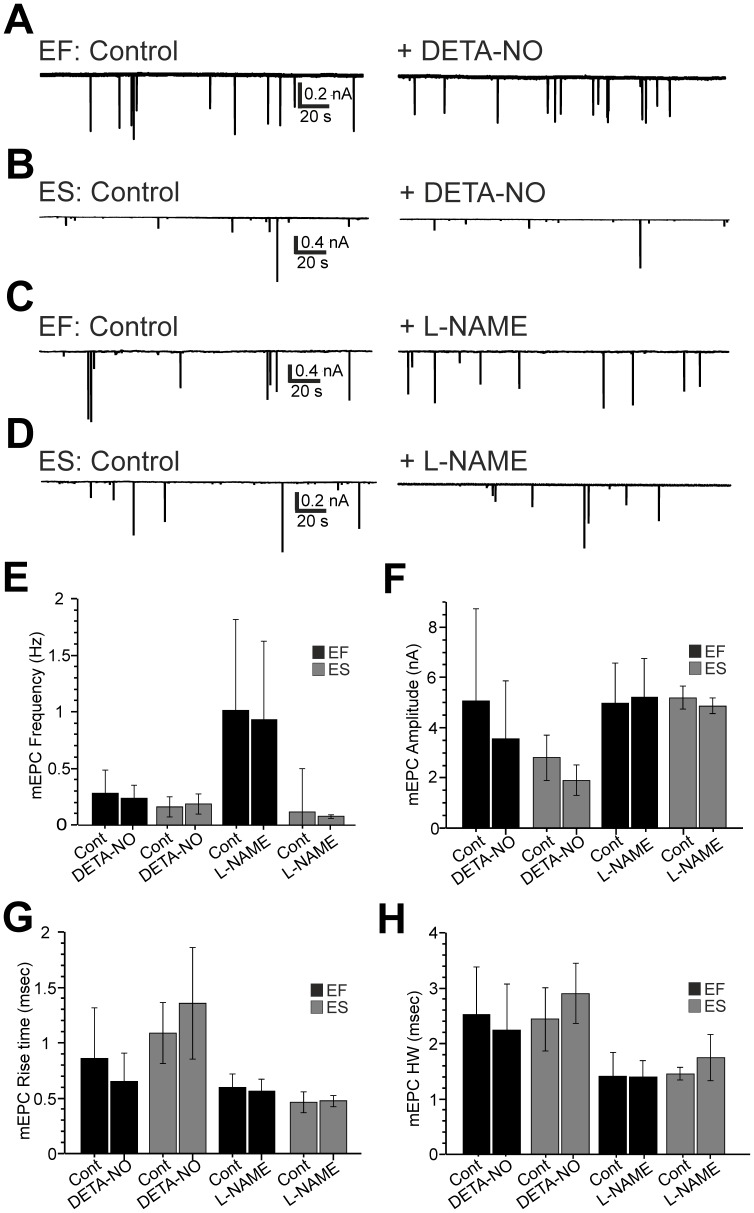
Acute manipulation of NO levels does not affect mEPC kinetics.
A–D. Representative sweeps of embryonic fast (EF) and embryonic slow (ES) miniature end plate currents (mEPCs) in control conditions and after a 10 minute exposure to either DETA-NO (A,B) or L-NAME (C,D). E–H. Bar charts depicting effects of acute DETA-NO/L-NAME application on mean mEPC frequency (E), amplitude (F) rise time (G) and half-width (H). Data in E–H are represented as mean ± SEM.